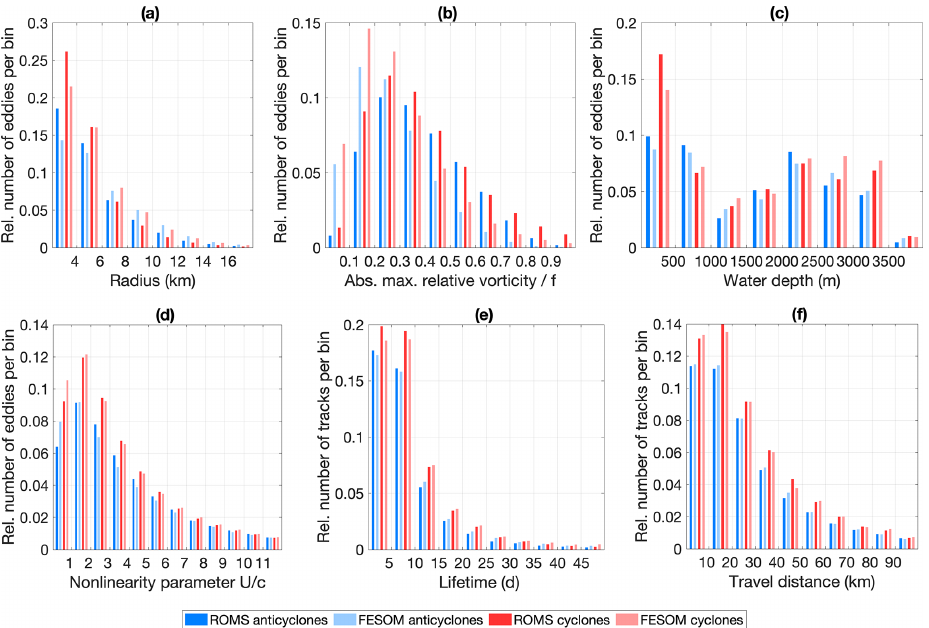
Figure 7. Histogram of (a) radius, (b) maximum relative vorticity normalised by f , (c) water depth, (d) eddy nonlinearity parameter U/c , (e) eddy lifetime and (f) travel distance for anticyclonic (blue) and cyclonic eddies (red) normalised by the number of eddies and/or tracks tracked in the area 8 ◦ W–20 ◦ E, 76–82 ◦ N in the years 2006–2009 in ROMS (dark colours) and FESOM (light